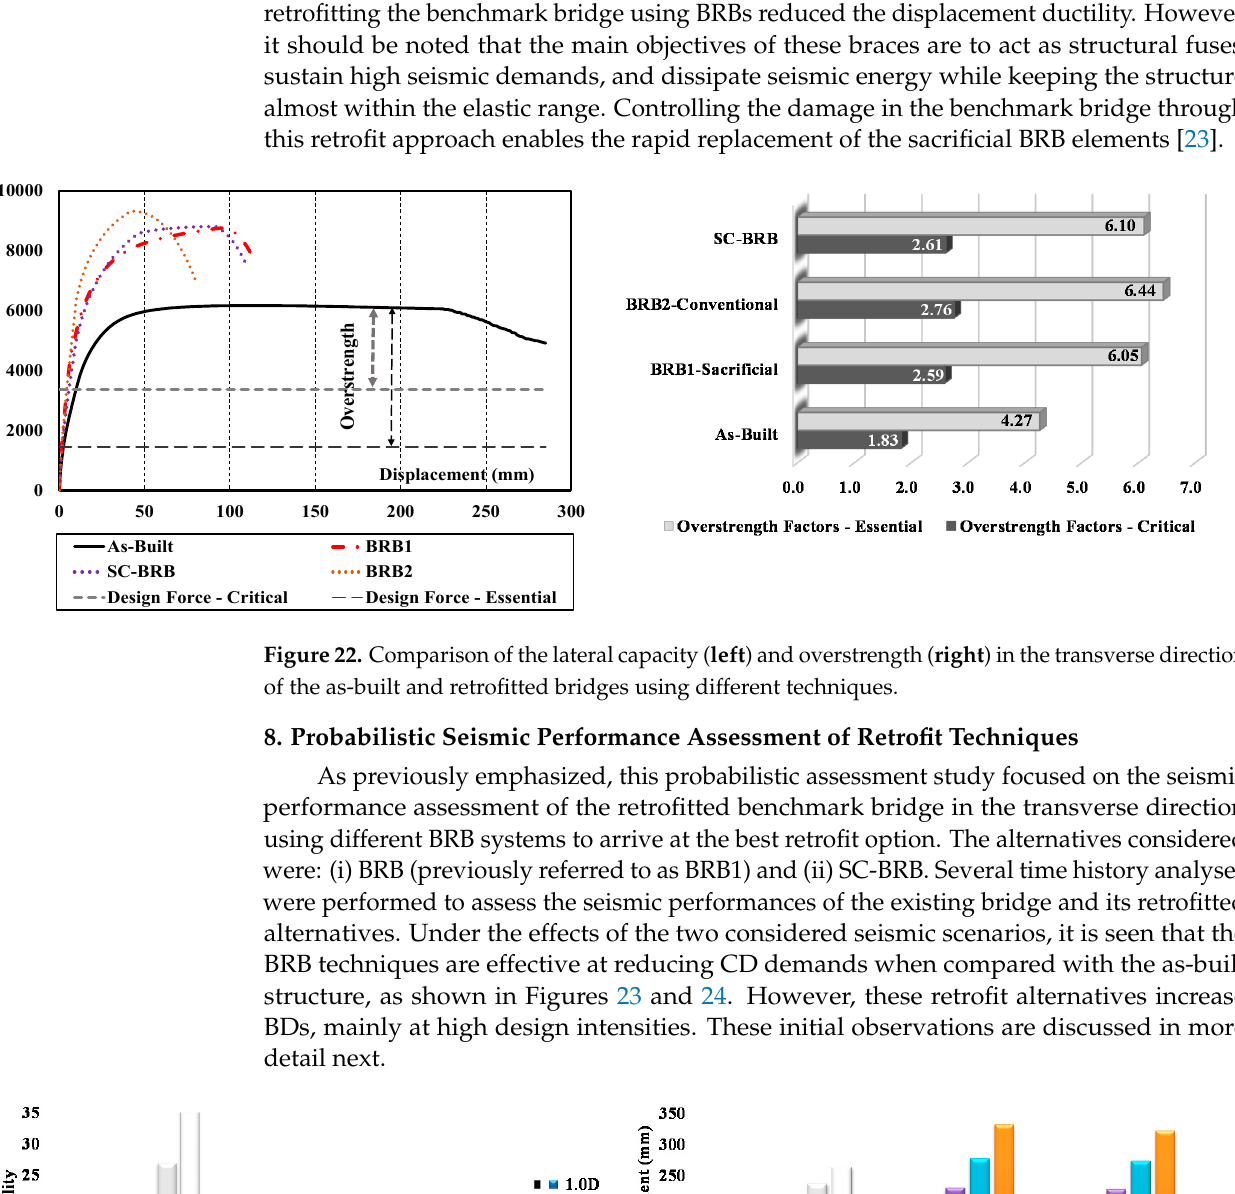
Figure 24. Observed CD ( left ) and BD ( right ) demands under near-field earthquake records when scaled to different design intensities. Figure 25. Fragility curves of bridge bent CD demands under far-field records in the transverse direction (as-built vs. retrofitted bridges with different BRB techniques).